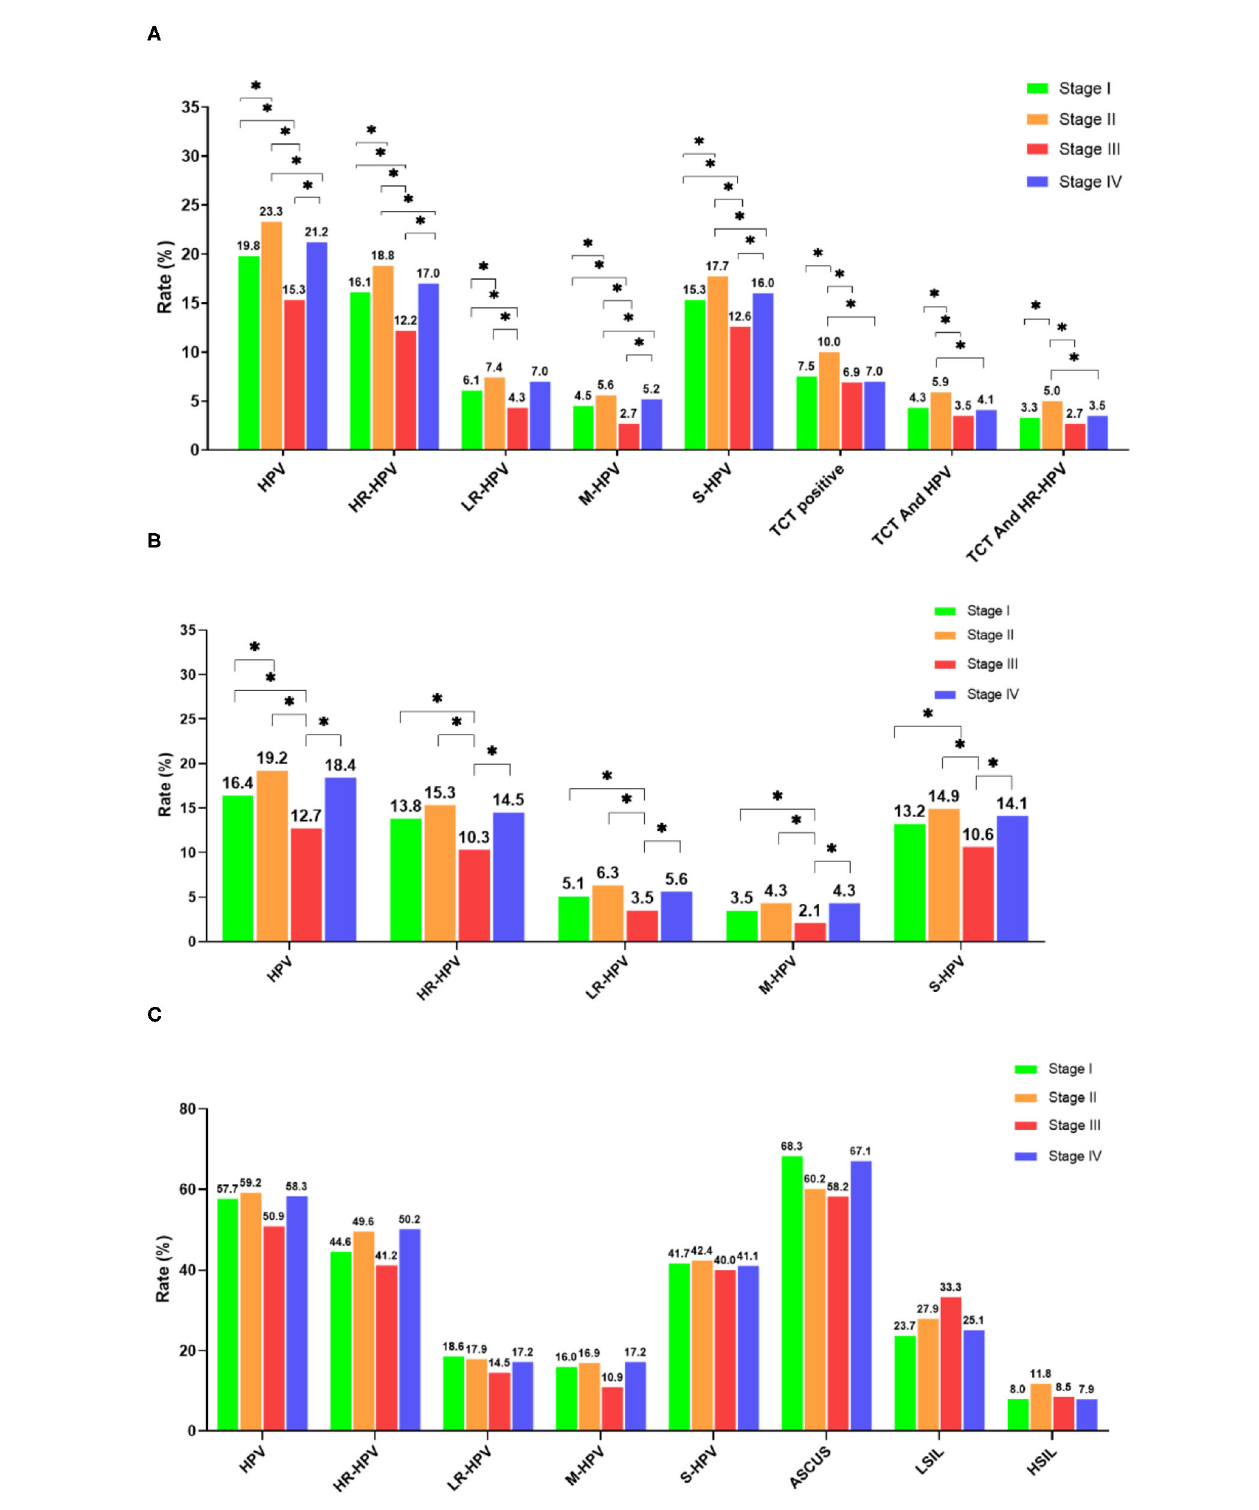
FIGURE 3 | Comparison of HPV infection rates in different stages. (A) Overall population; (B) TCT normal population; (C) TCT abnormal population. * P < 0.05 and ** P < 0.01.